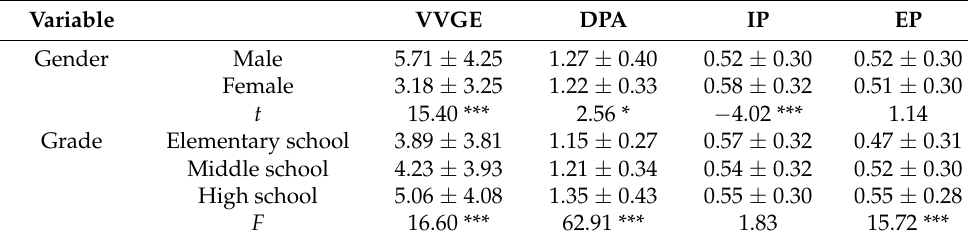
Table 3. Difference